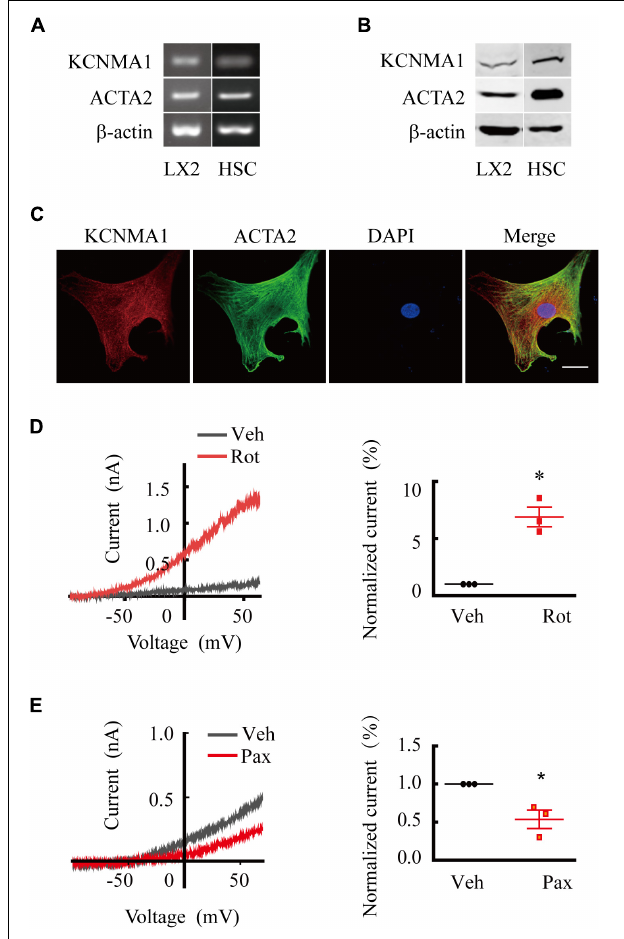
FIGURE 1 | Large-conductance and Ca 2 + -activated K + (BK) channels are expressed and functional in activated hepatic stellate cells (HSCs). (A,B) Representative RT-qPCR (A) and western blots (B) showing the expression of ACTA2 and the BK channels alpha subunit KCNMA1 in activated human LX2 cells treated with transforming growth factor beta 1 (TGF β 1) and spontaneously activated primary rat HSCs in vitro . (C) Representative immunofluorescence images of KCNMA1 and ACTA2 in activated primary rat HSCs (Scale bars, 25 µ m). (D,E) Representative whole-cell K + current traces and the normalized current recorded from activated HSCs before and after treatment with rottlerin (Rot) and paxilline (Pax), as indicated at 1 µ M internal Ca 2 + . The whole-cell currents were elicited by 1 s voltage ramps from − 100 to 80 mV. Rottlerin (1 µ M) and paxilline (10 µ M) were freshly prepared from stock solutions and the final DMSO concentration was 0.1% (* p < 0.05 compared with the vehicle group, n =